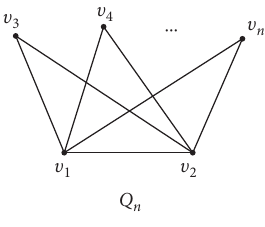
Figure 1: The graph Q